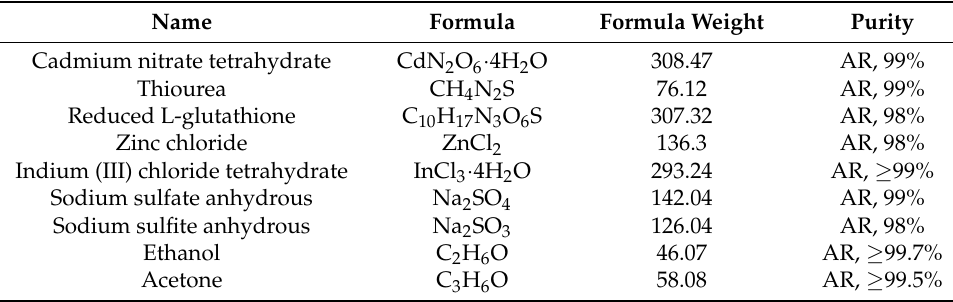
Table 1. List of chemicals used in the experiments. Name Formula Formula Weight